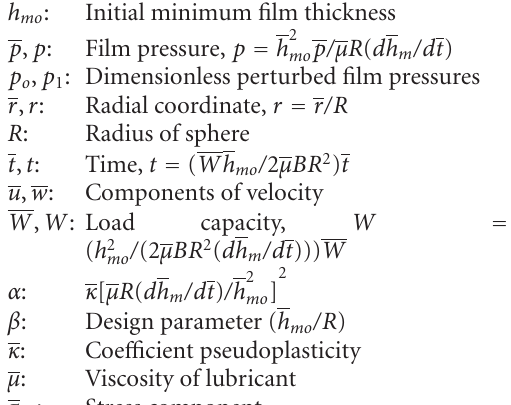
Figure 5: Variation of dimensionless squeeze time with respect to the squeezed film thickness h f for di ff erent values of parameter α .